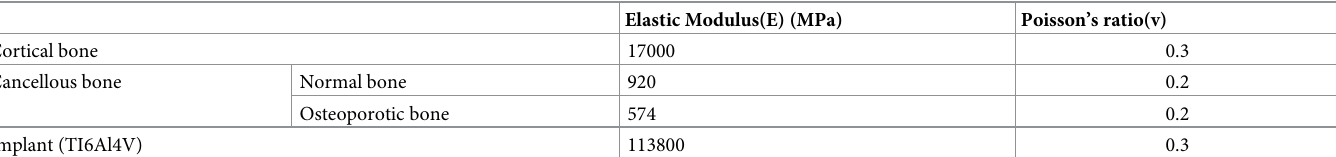
Table 1. Material properties applied for the finite element model